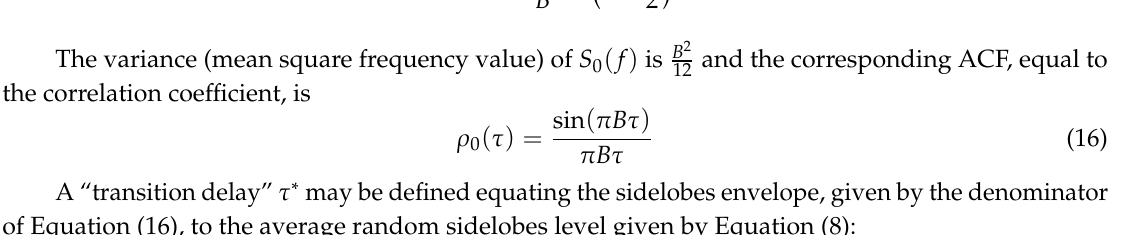
δ with BT varying, Equation